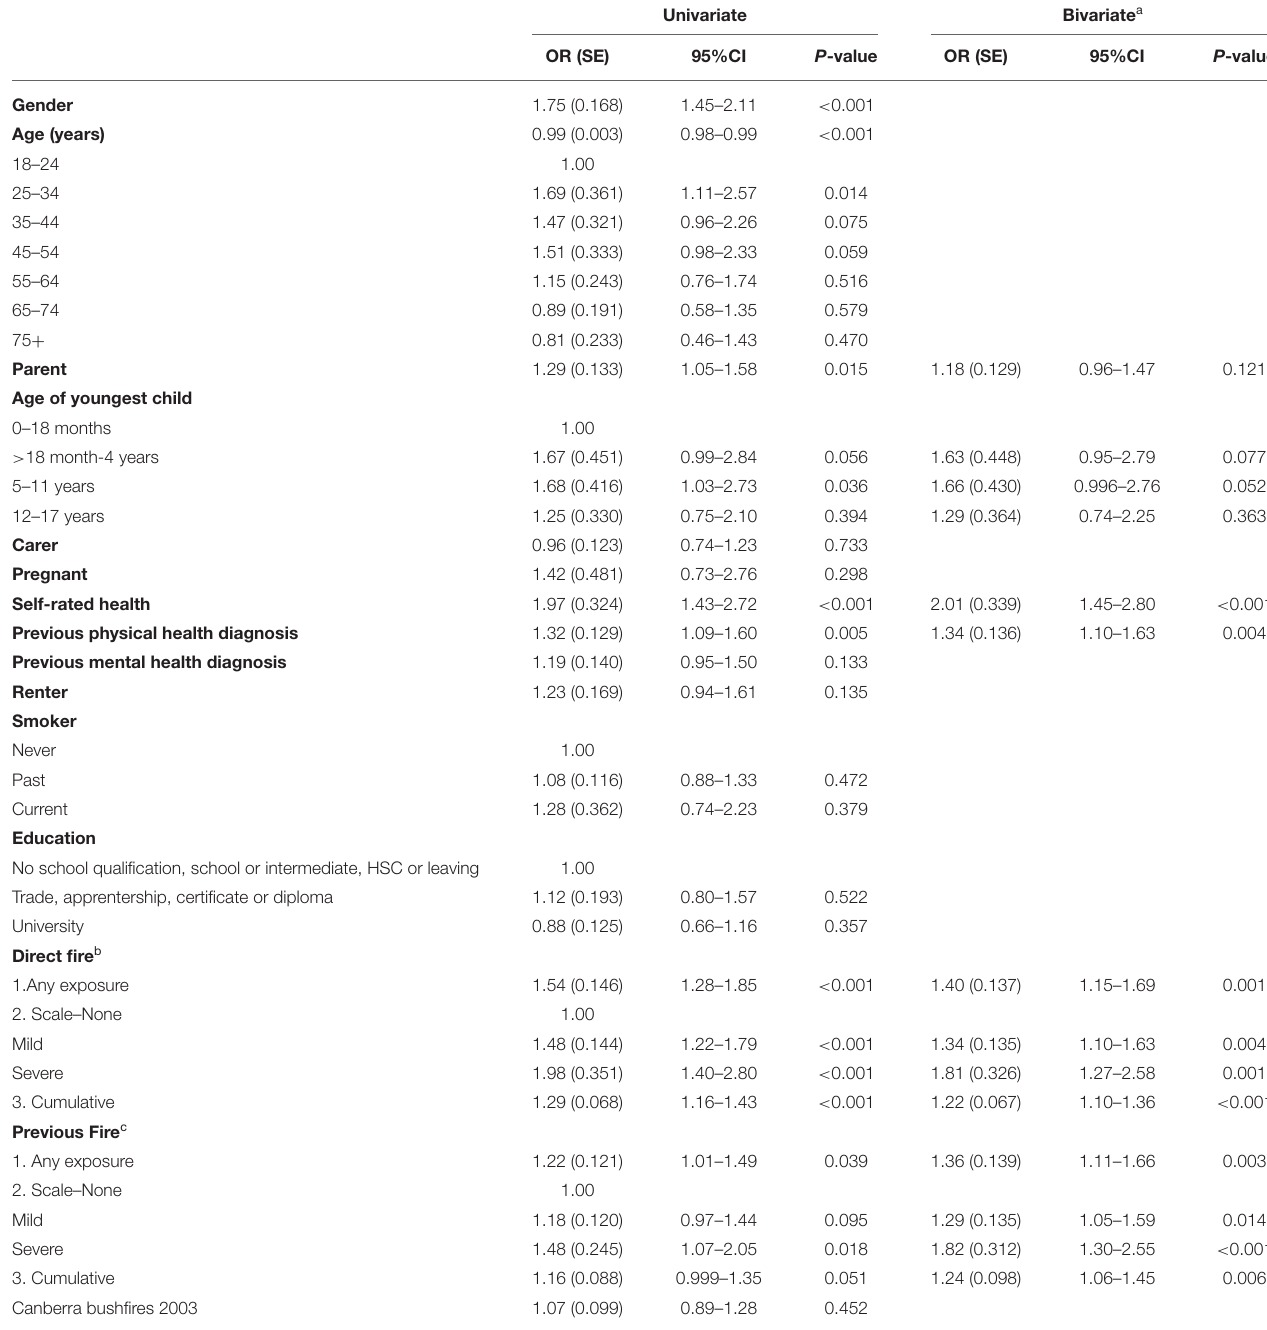
TABLE 6 | Logistic regression examining factors associated with negative self-reported sleep outcomes attributed to bushfire smoke